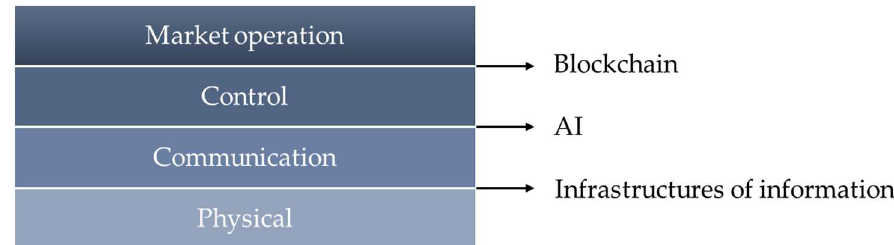
Figure 7. Blockchain applications in smart